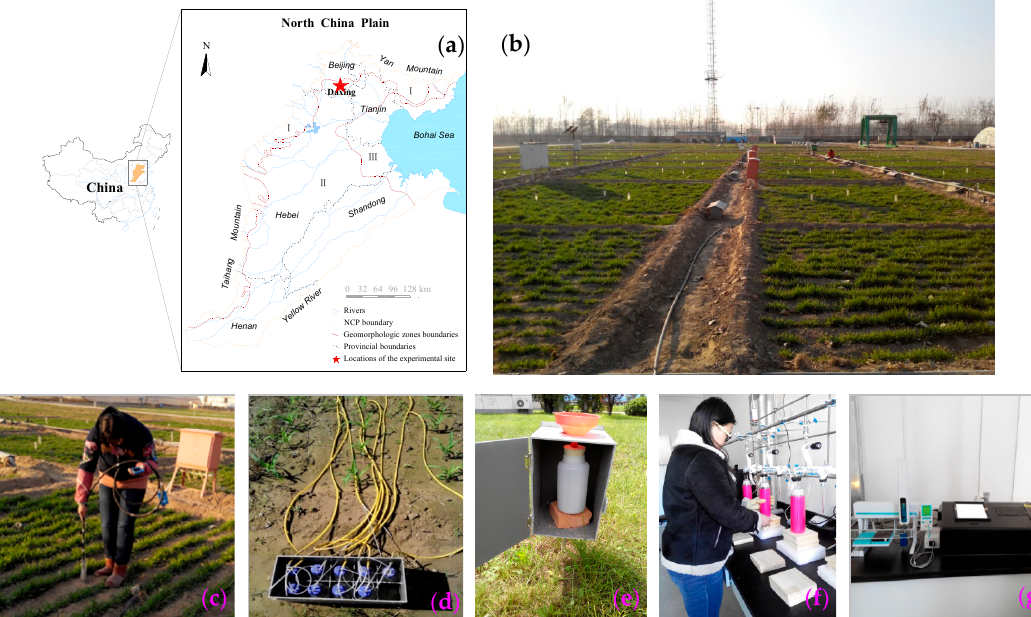
Figure 1. Schematic for the ( a ) location of the experimental site, ( b ) experimental plots, ( c ) soil water content measurement, collection of ( d ) soil water and ( e ) precipitation samples, ( f ) water extraction from soil and stem samples, and ( g ) isotopic analysis via the LGR. Table 1. Physical and chemical properties of the soil profile at the experimental site. Depth